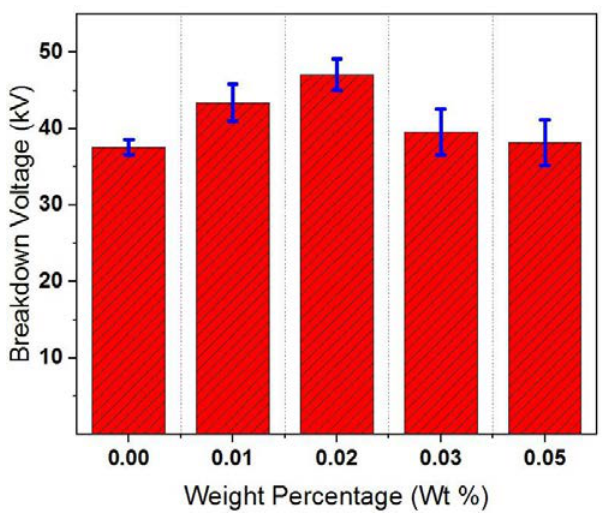
Figure 5. AC Breakdown voltage of GO-based cottonseed oil (CSO) nanofluids at different weight Figure5. percentages.